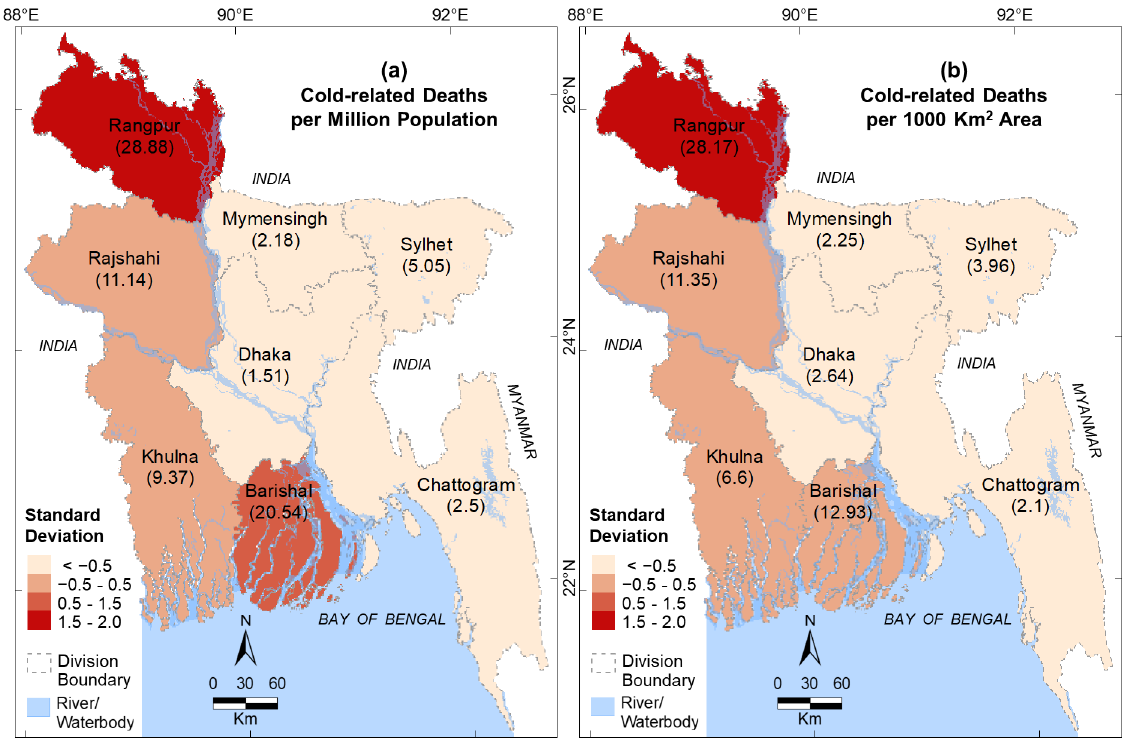
Figure 3. Standard deviations for ( a ) cold-related deaths per million population and ( b ) per 1000 km 2 area in the divisions of Bangladesh during 2009–2021. The numbers in brackets represent the specific absolute value of the division.